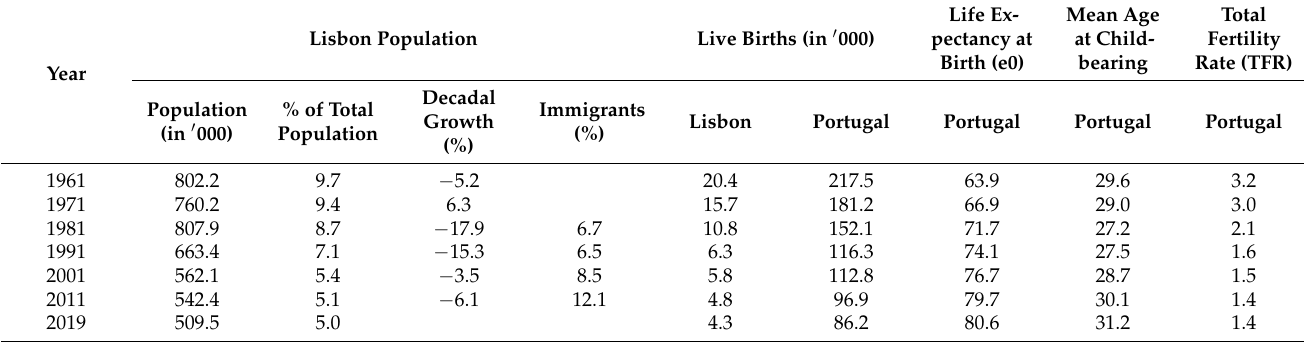
Life Ex- Mean Age Total pectancy at at Child- Fertility Birth (e0) bearing Rate